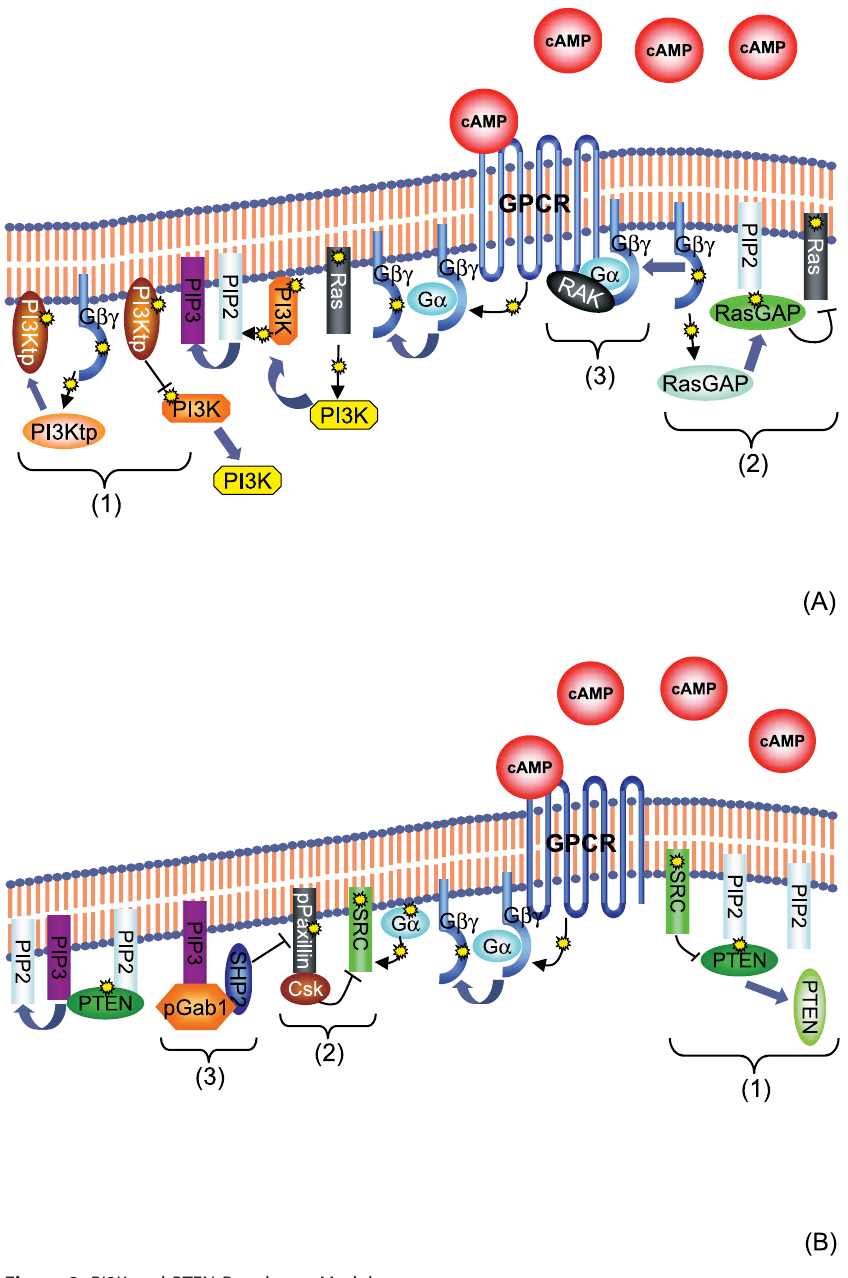
Figure 2. PI3K and PTEN Regulatory Modules (A) Elements controlling the activity of PI3K and upstream components. In addition to the basic, ‘‘ excitatory, ’’ signaling elements like the cAMP receptor, G bc , and Ras, we introduced further elements controlling the activity of PI3K and upstream components. ‘‘ PI3Ktp ’’ (module 1) stands for